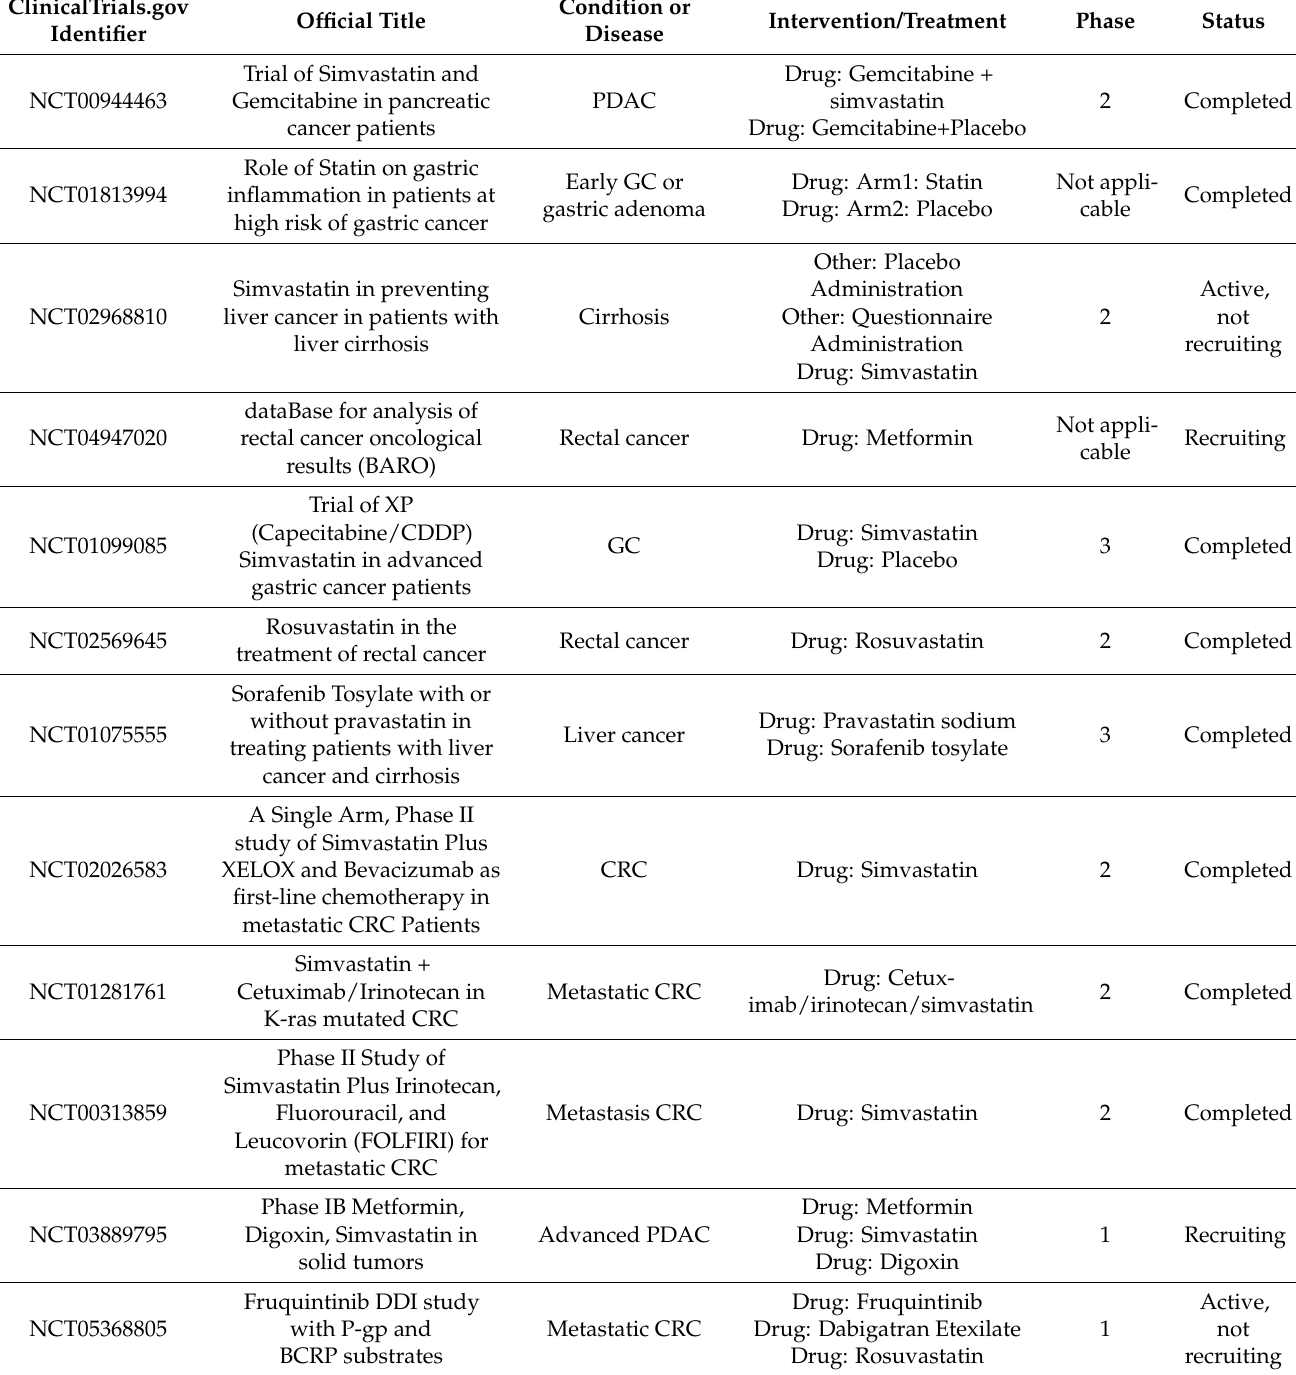
Table 3. Clinical trials on Hippo inhibitors-based therapy in GI